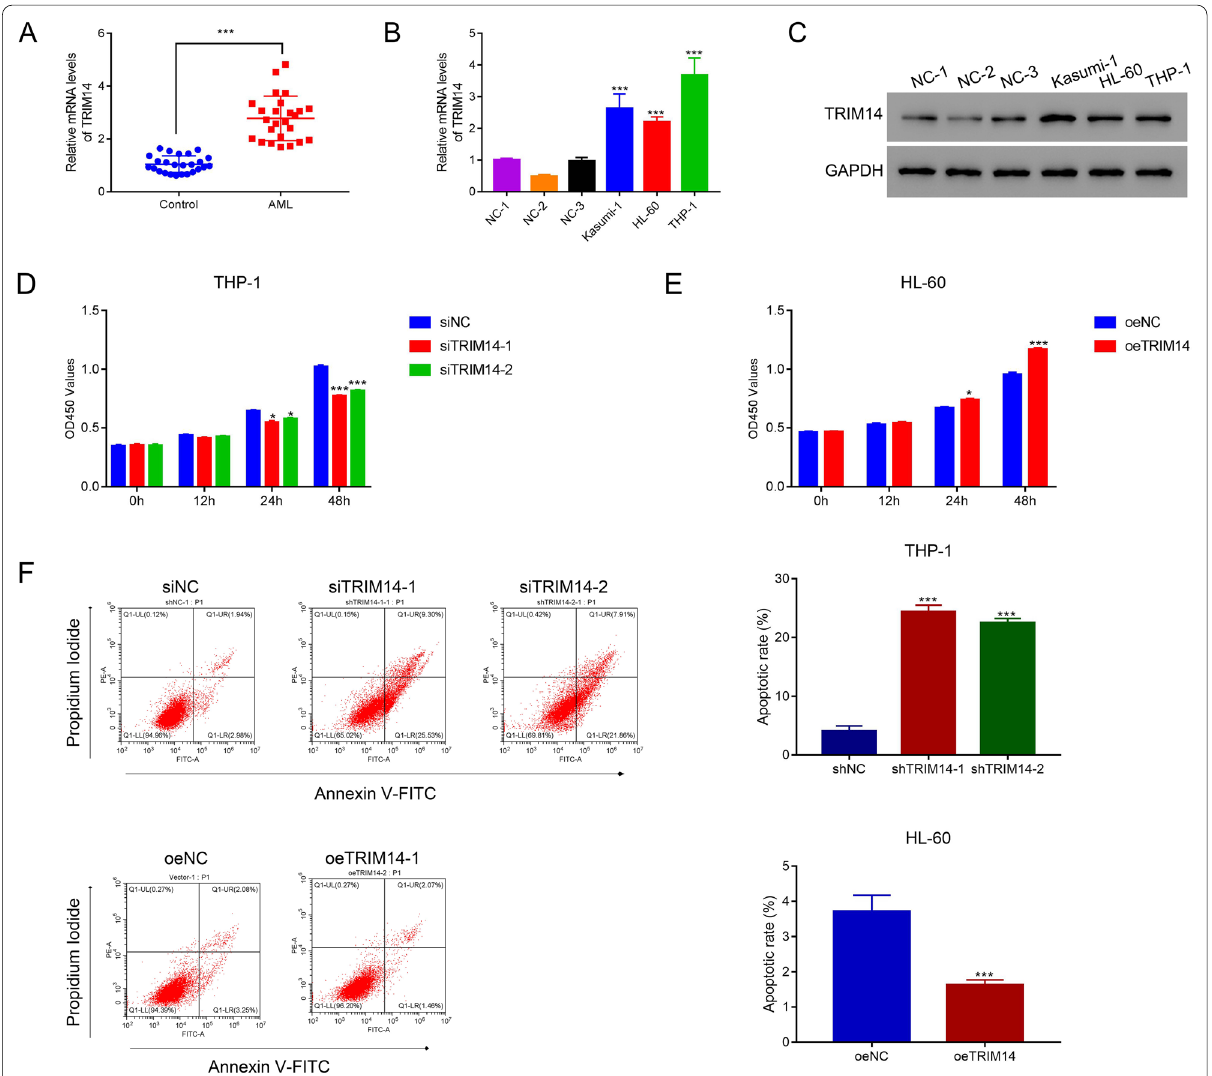
Fig. 1 TRIM14 promoted the proliferation and reduced the apoptosis of AML cells. A The serum level of TRIM14 in AML patients compared with healthy donators (n 25 for each group). B – C The mRNA ( B ) and protein ( C ) levels of TRIM14 in AML cell lines compared with three human normal = bone marrow cells 1–3. D The proliferation of THP-1 cells after transfecting with siNC, siTRIM14-1 and siTRIM14-2. E The proliferation of THP-1 cells after transfecting with TRIM14 overexpressed plasmid. F Flow cytometry detected the apoptosis of THP-1 cells after transfecting with siTRIM14-1 and siTRIM14-2. G Flow cytometry detected the apoptosis of THP-1 cells after transfecting with TRIM14 overexpressed plasmid and control plasmid. * p < 0.05; *** p <